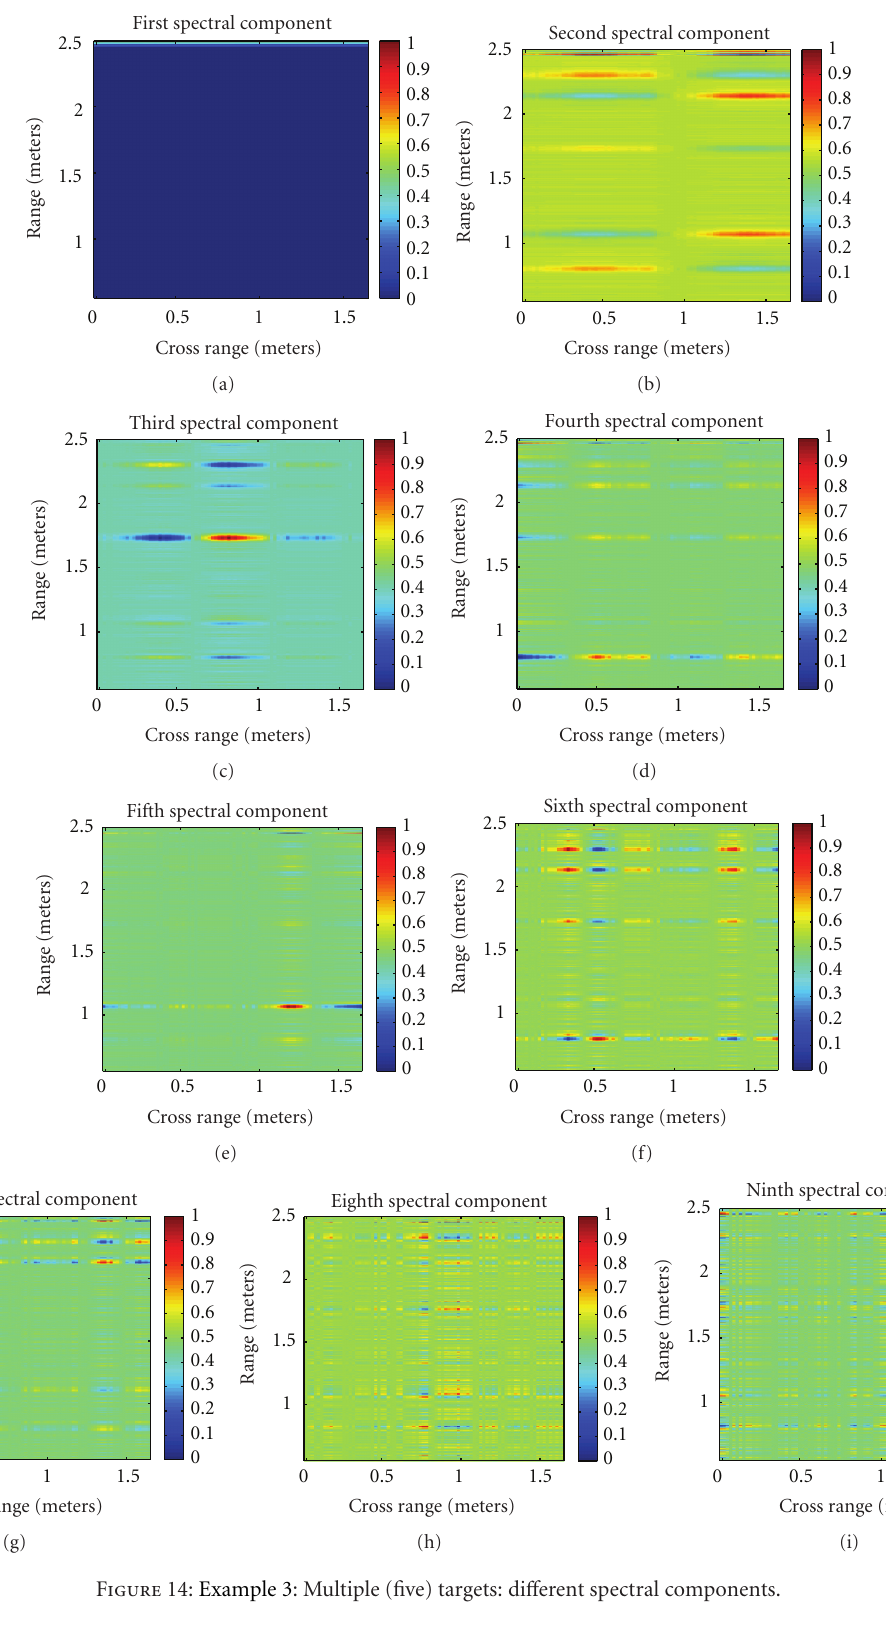
Figure 14: Example 3: Multiple (five) targets: di ff erent spectral